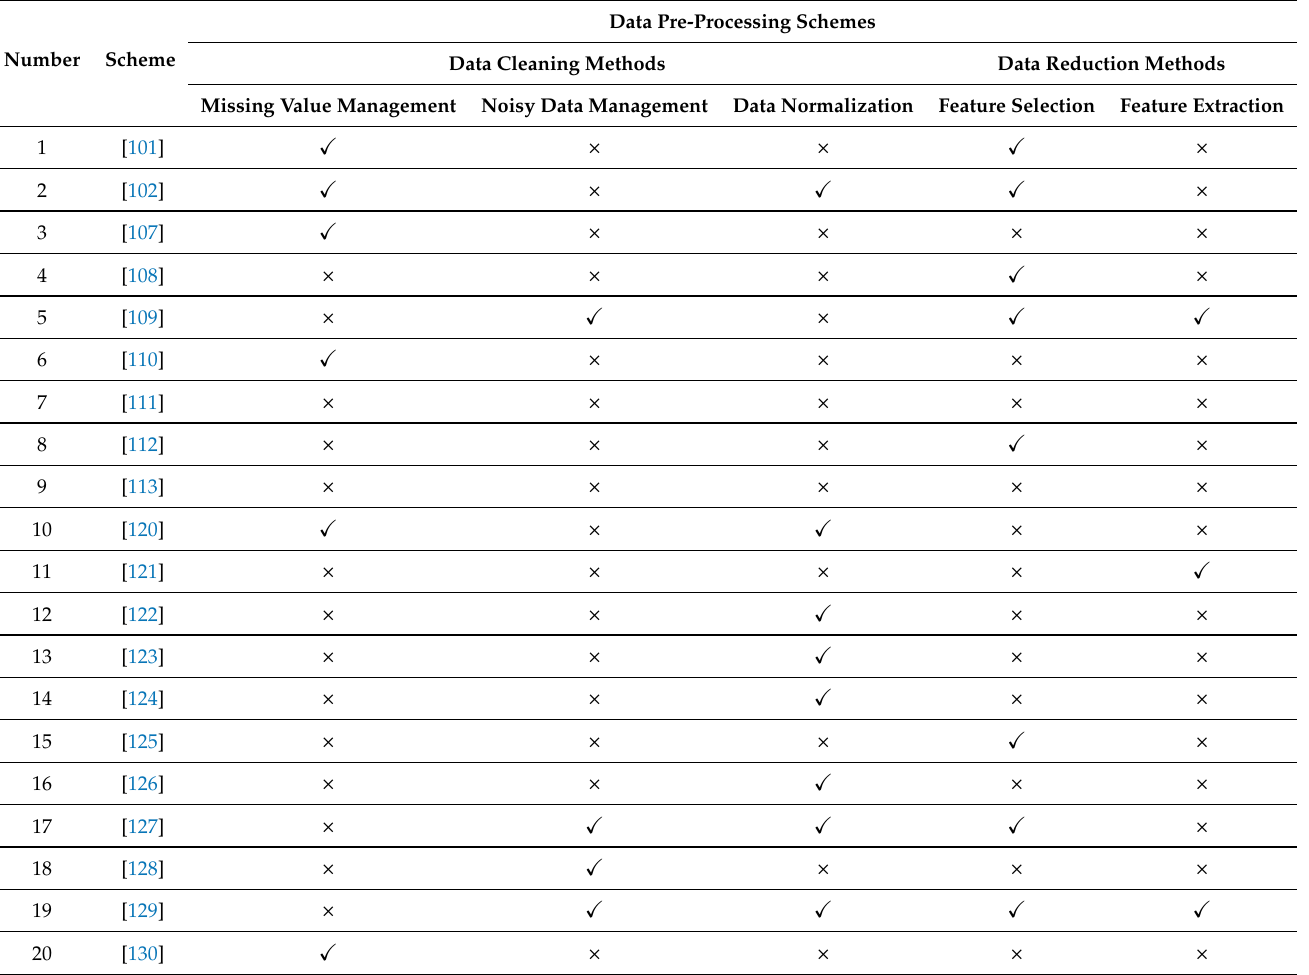
Table 16. Classification of ML-based methods in terms of data pre-processing schemes. Data Pre-Processing Number Scheme